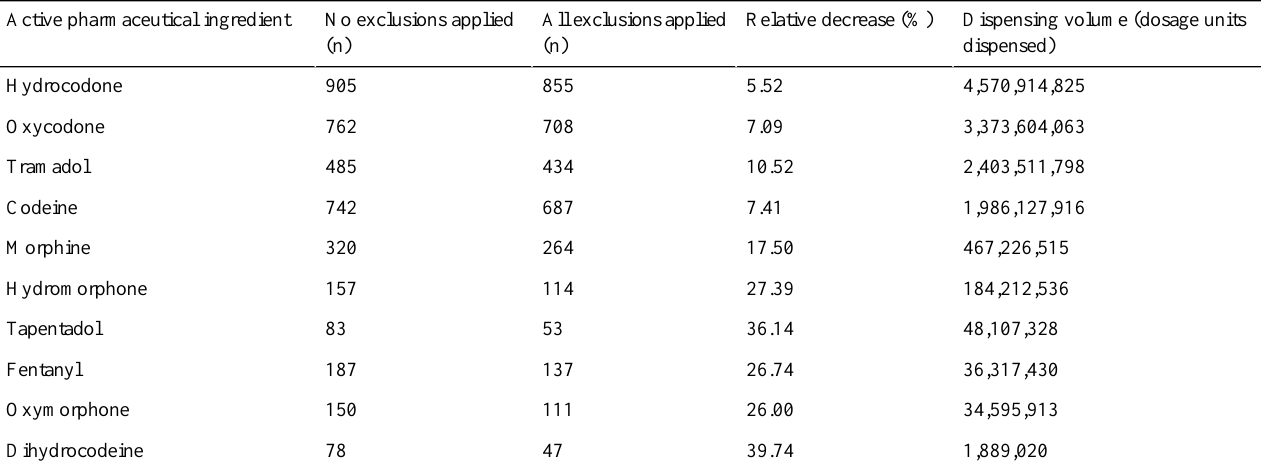
Table 2. Relative decrease in prescription drug nonmedical use endorsements after exclusions compared with drug